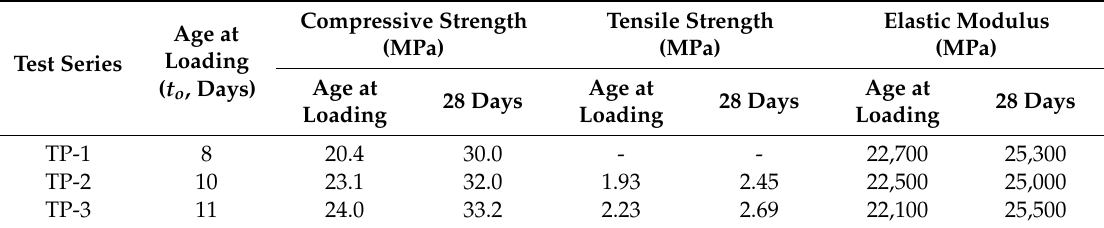
Table 2. Elastic moduli and compressive strengths at 28